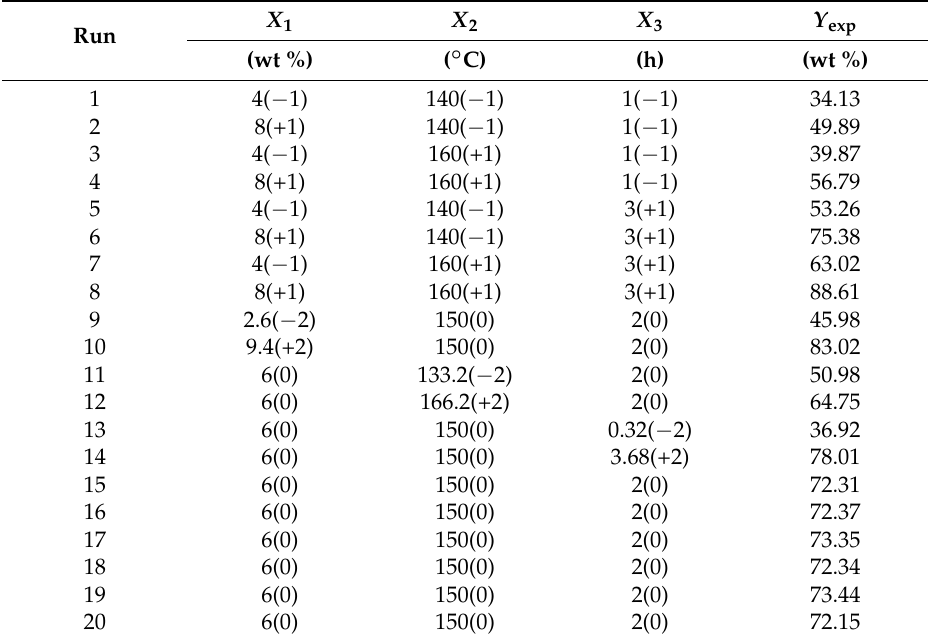
Table 3. Experimental design matrix.